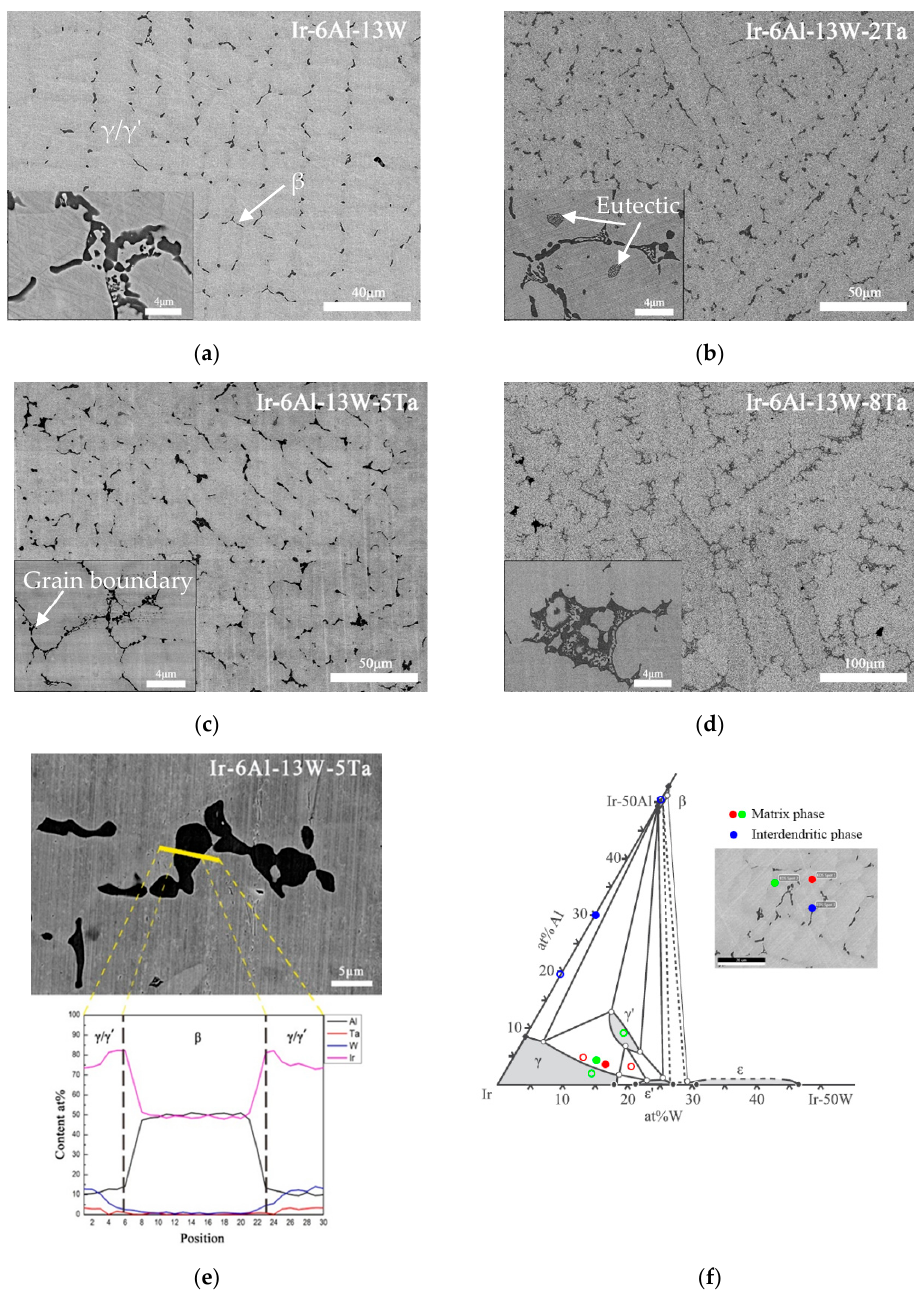
Figure 3. Back Scattered Electron (BSE) images of the as-cast ternary and quaternary alloys: ( a ) Ir–